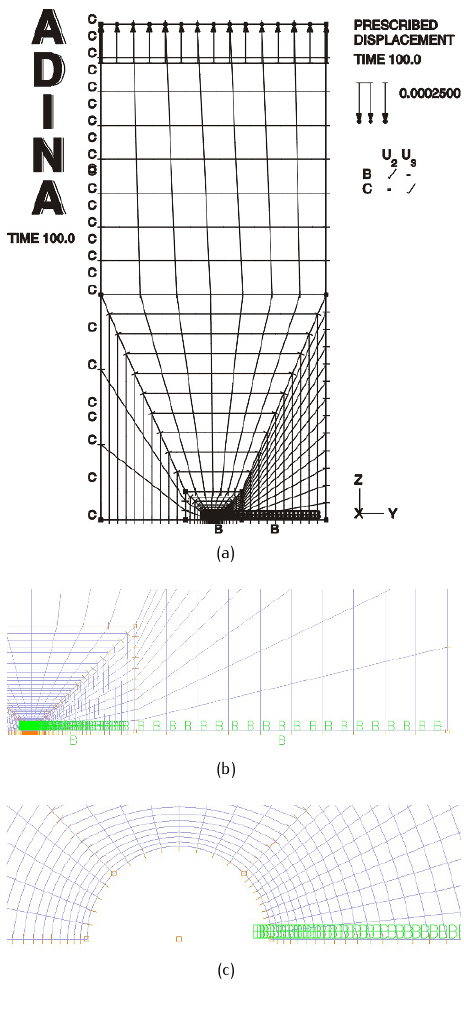
Figure 7. (a) The finite element model for CC(T) specimen used in the FEM analysis assuming large strain option; (b) The finite element mesh near crack tip; (c) Sample finite ele- ments mesh around the crack